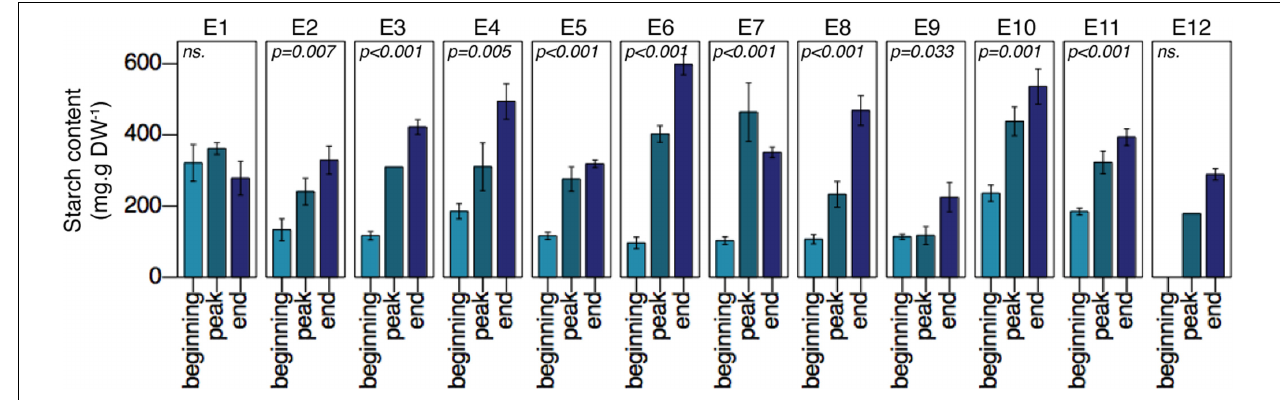
FIGURE 2 | Zostera noltei starch content in rhizome over the growing season (three experimental periods on x -axis) along a Western European latitudinal gradient (sites E1–E12). Statistical values ( p -values) indicate significant changes in starch content throughout the experimental period (ns: non-significant effects).